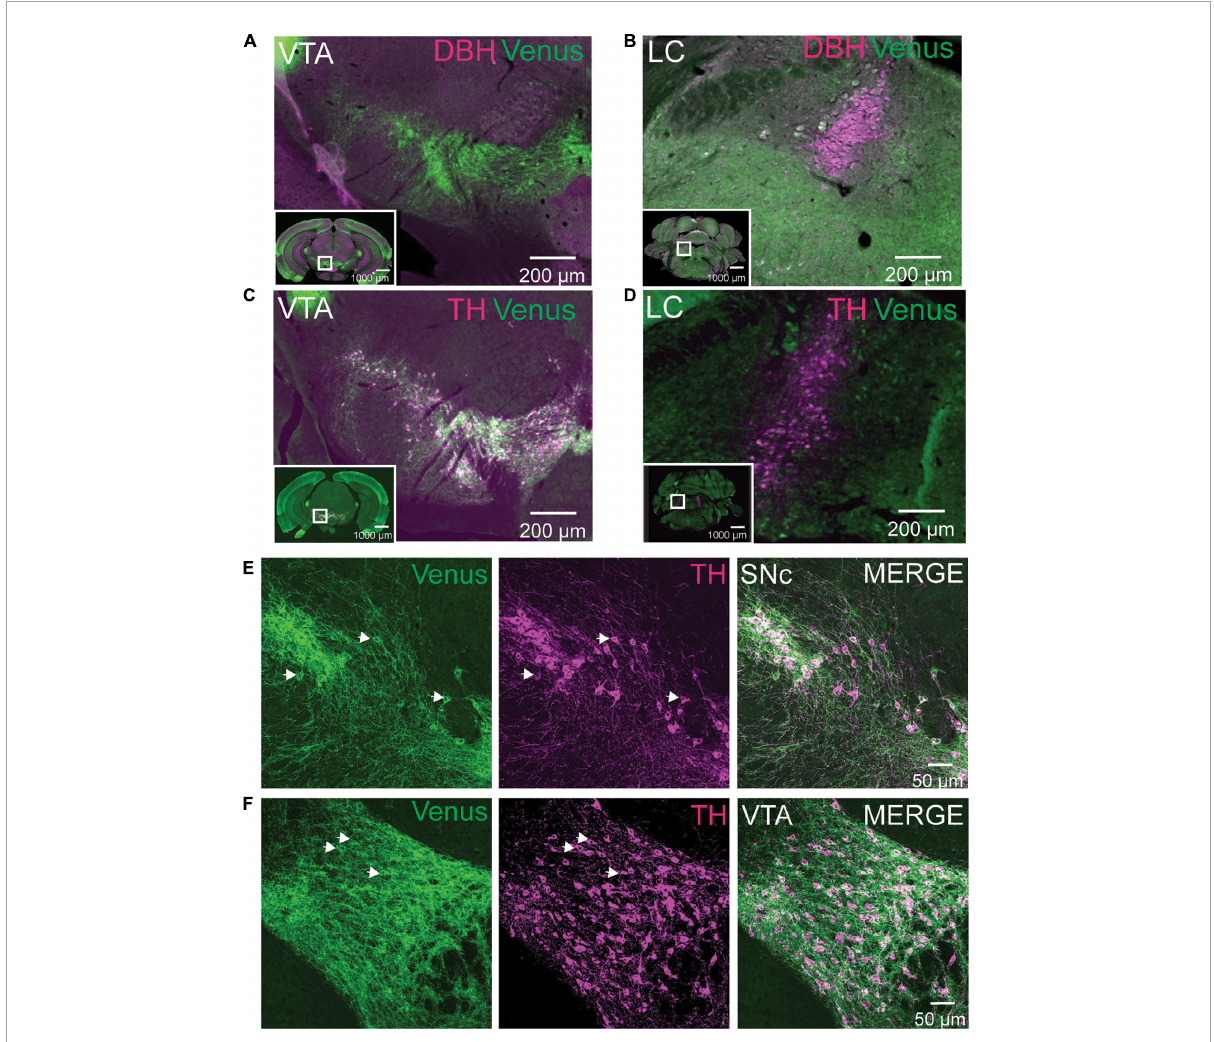
FIGURE4 NTSR1-Venus neurons are dopaminergic VTA neurons. (A,B) Tissue sections from Ntsr1 Venus / Venus animals were stained with anti-Venus (green) or noradrenergic cell marker anti-dopamine- β -hydroxylase (DBH) shown in magenta. Neurons in midbrain dopaminergic regions ventral tegmental area (VTA) (A) , and noradrenergic locus coeruleus (LC) (B) are shown. (C,D) Tissue sections from Ntsr1 Venus / Venus animals were stained with anti-Venus (green) or dopaminergic cell marker anti-tyrosine hydroxylase (TH) shown in magenta. Co-labeling was assessed in VTA (C) and LC (D) . For panels (A–D) , co-labeled cells are shown in white. Scale bars are 1000 µ m for the macro view (insets) and 200 µ m for the magnified view. White boxes found on insets highlight areas of magnification. Images were acquired with epifluorescence on an Olympus VS120 slide scanner. (E,F) Tissue sections from Ntsr1 Venus / Venus animals were stained with anti-Venus (green) or dopaminergic cell marker anti-TH (magenta). Confocal images of co-labeled NTSR1-Venus and dopaminergic neurons in substantia nigra compacta (SN) (E) and VTA (F) are shown. Scale bars are 50 µ m. (A–F) Images are representative of n = 3 Ntsr1 Venus / Venus